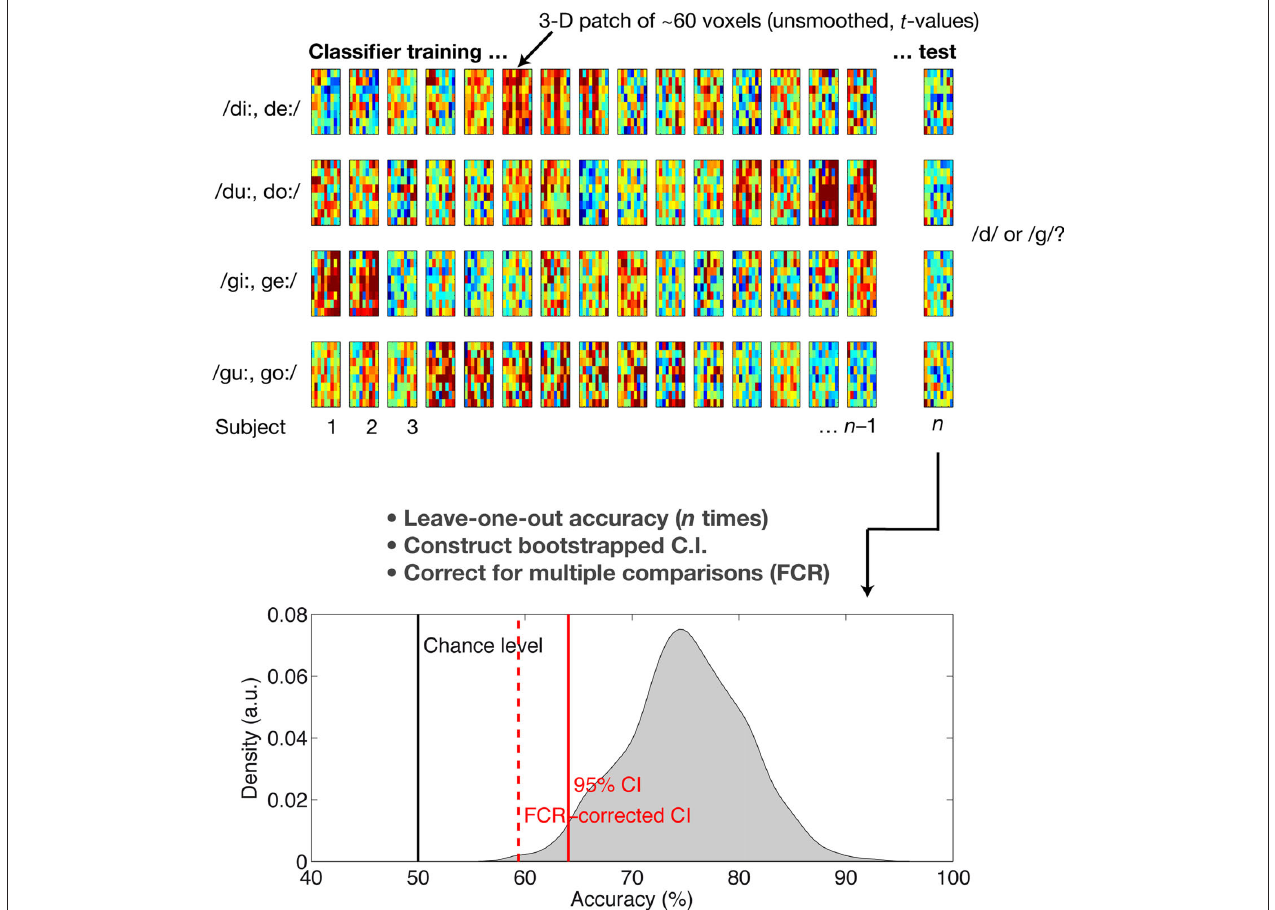
the entire procedure at this voxel patch was repeated n times. The resulting average accuracies were bootstrapped (1000 repetitions) to attain 95% confidence limit estimates, which, in a last step, were also corrected for multiple comparisons (false coverage statement rate, FCR, see text; dashed line in bottom panel). A voxel patch was termed “accurate” in classification only when revealing an FCR-corrected confidence limit not covering the 50% chance